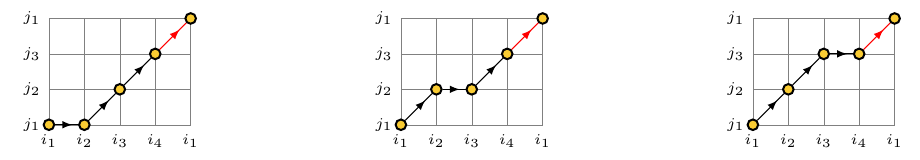
Figure 13. The three terms in W PQ coming from a quartic T P and a cubic T Q . Red arrows represent the products of a field in p and a field in q . Black arrows descend from fields that are not in p or q